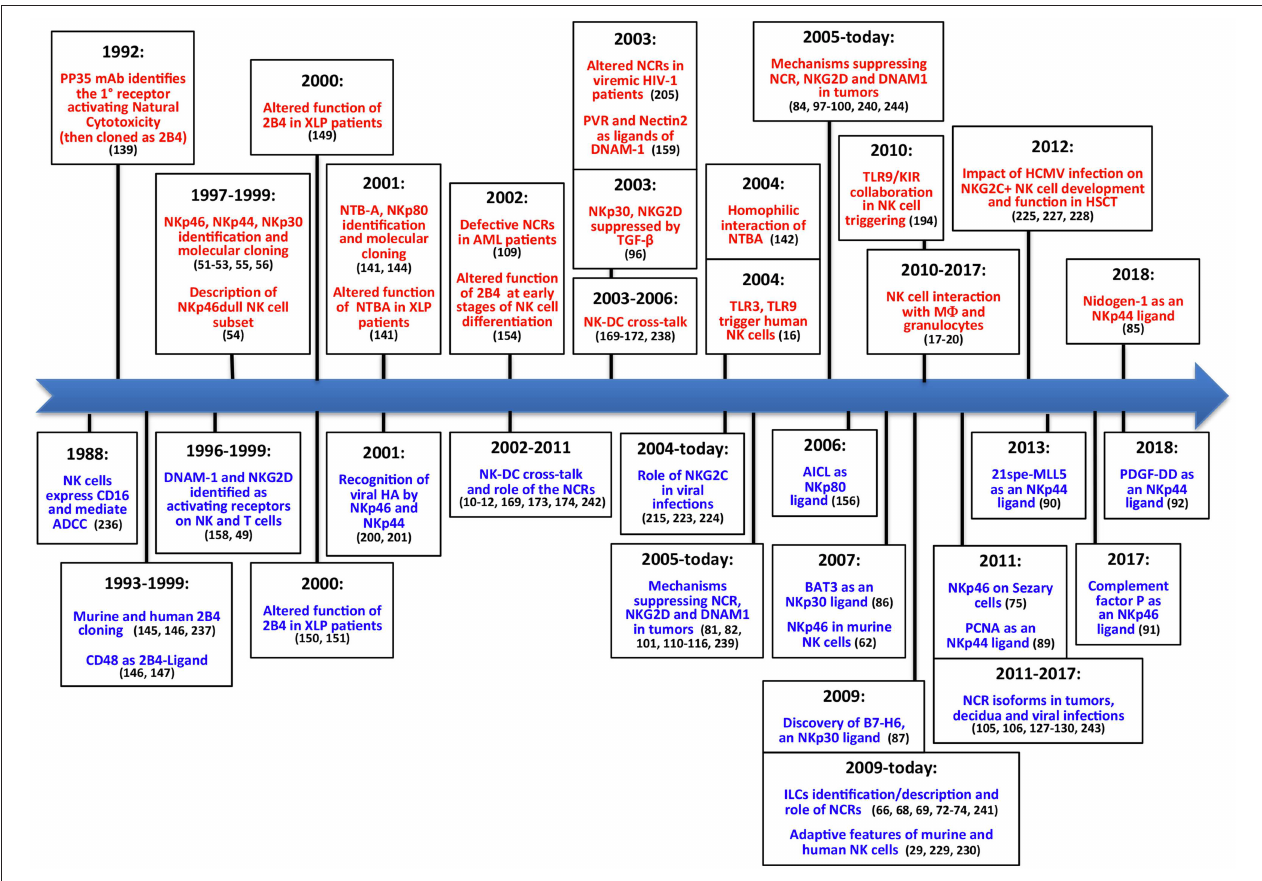
FIGURE 2 | The main steps concerning activating NK receptors/coreceptors. The timeline illustrates the main discoveries concerning NK cell activating receptors during a timespan of about 30 years. Contributions deriving from Alessandro Moretta’s research group are indicated in red (upper part) , while contributions obtained by other groups are shown in blue (lower part)